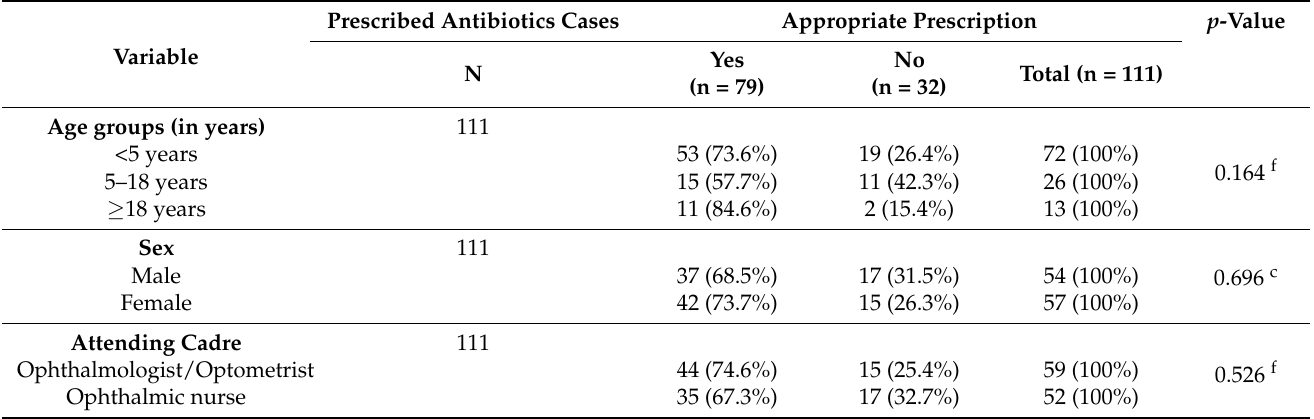
Ghana from 1 January to 31 December